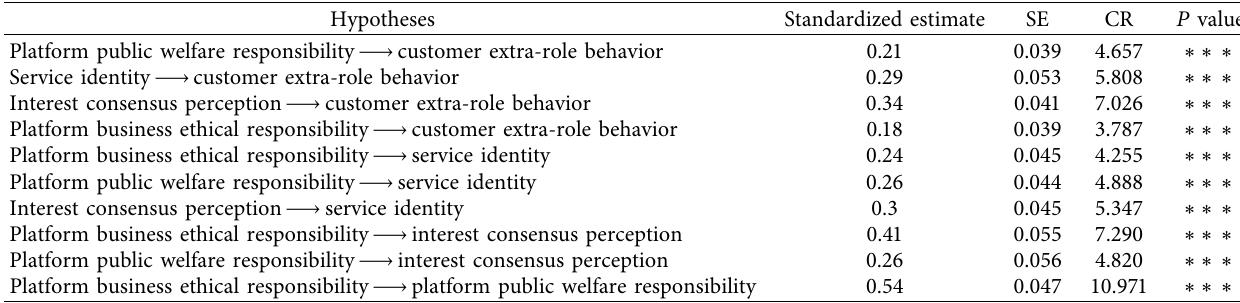
Table 8: Standardized structure estimation of research model.